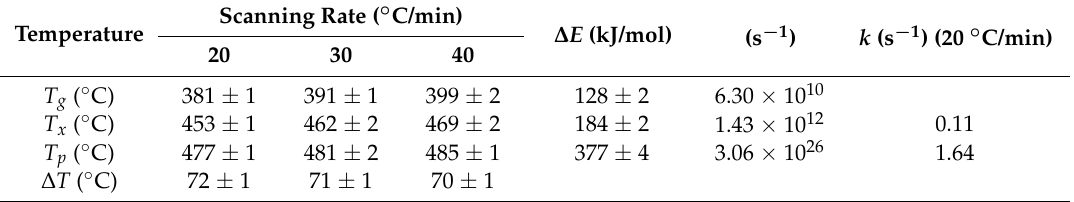
Table 3. The characteristic temperatures, activation energy, and crystallization constant after one